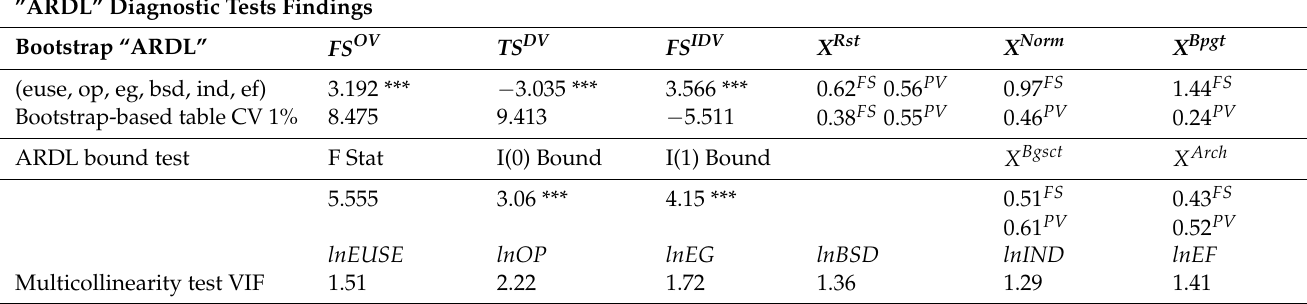
Table 3. Bootstrap “ARDL” co-integration test.